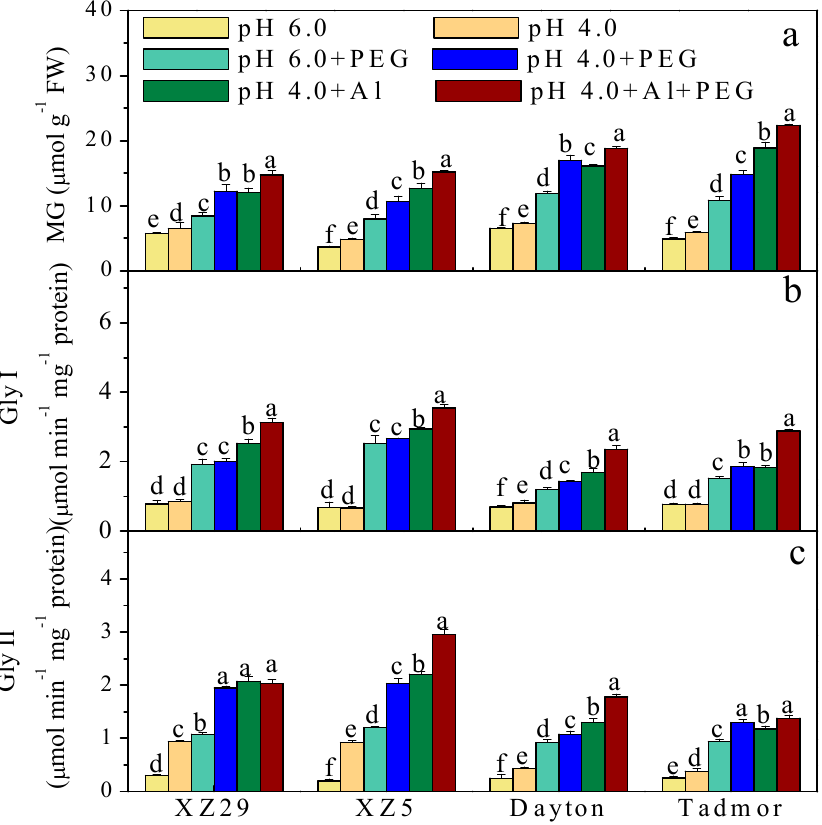
Figure 5. Effects of pH, PEG, Al, and pH 4.0+Al+PEG stresses on the ( a ) MG content and ( b ) Gly I and ( c ) Gly II activities of four barley genotypes seven days after treatment. Error bars represent SD values ( n = 6). Different letters indicate significant differences among the treatments within each genotype according to Duncan’s multiple range test with p <